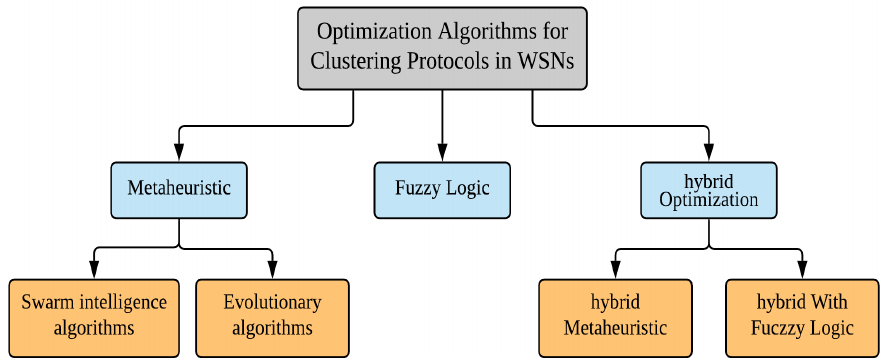
Figure 10. Classification of algorithms used in relevant articles.